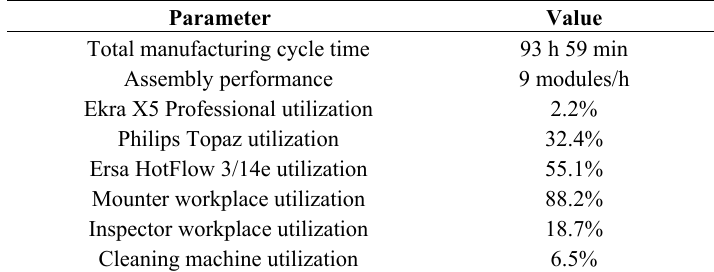
Fig. 8. The main results of simulation based on the created model of the assembly line with one mounter workplace: (a) statistics of the component pick-and-place machine Philips Topaz; (b) statistics of the reflow oven Ersa HotFlow 3 / 14e. Table 1. Summary operation statistics of the assembly line with one mounter